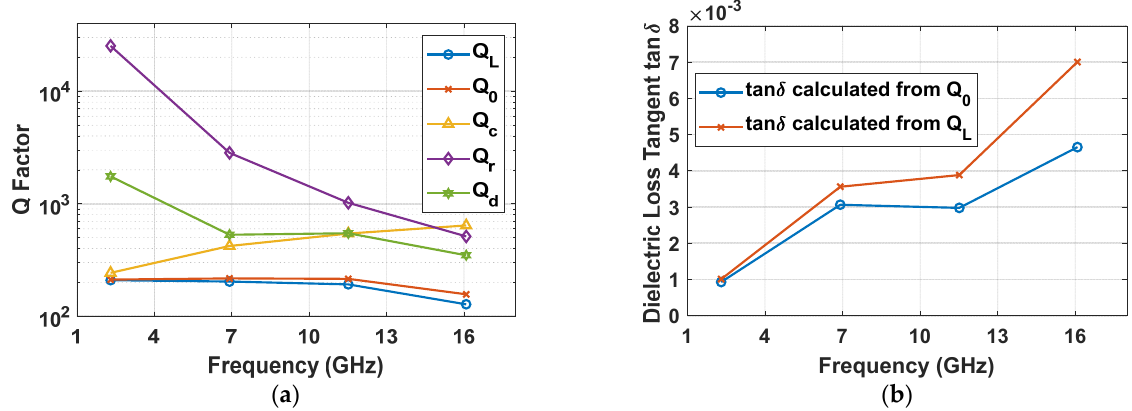
Figure 6. ( a ) The various parts of quality factors (conductor quality factor Q c , radiation quality factor Q r , dielectric quality factor Q d ) and ( b ) the difference of the dielectric loss tangent values when they are calculated from the loaded ( Q L ) and unloaded quality factors ( Q 0 ) for sample 3.